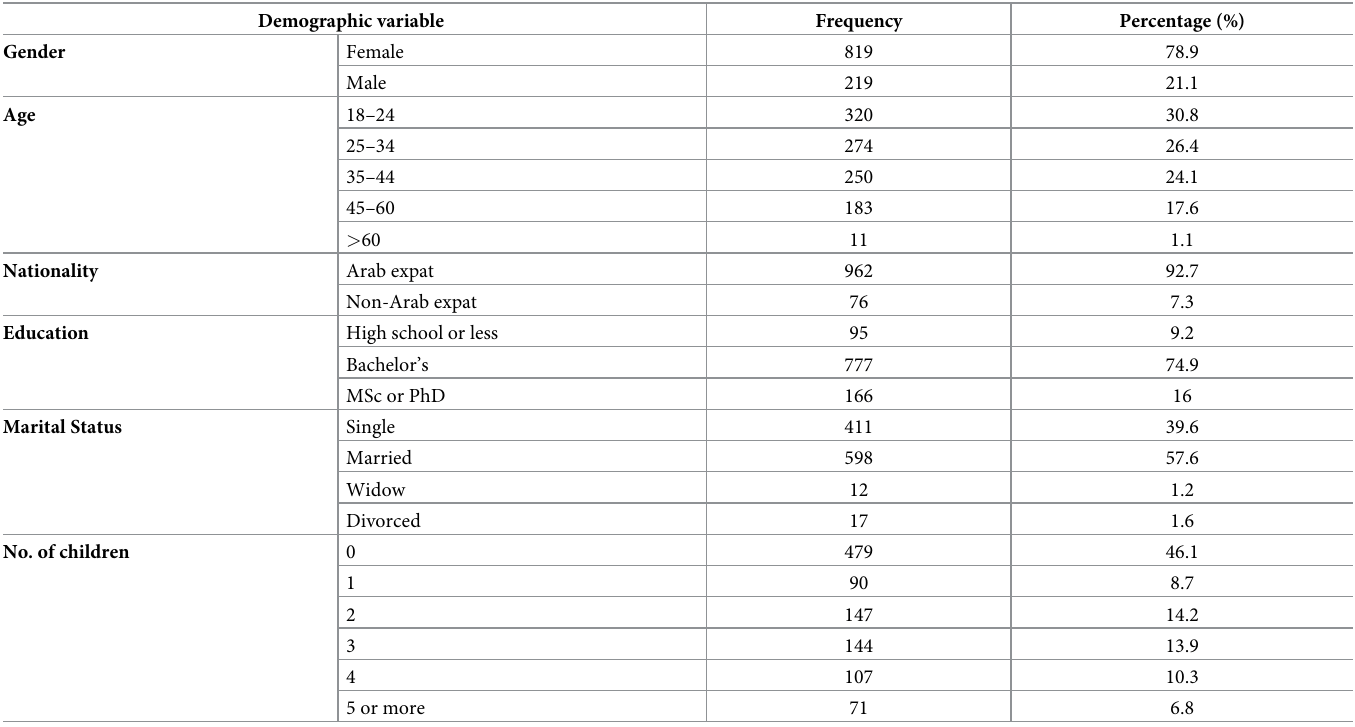
Table 1. Socio demographic characteristics of the respondents.